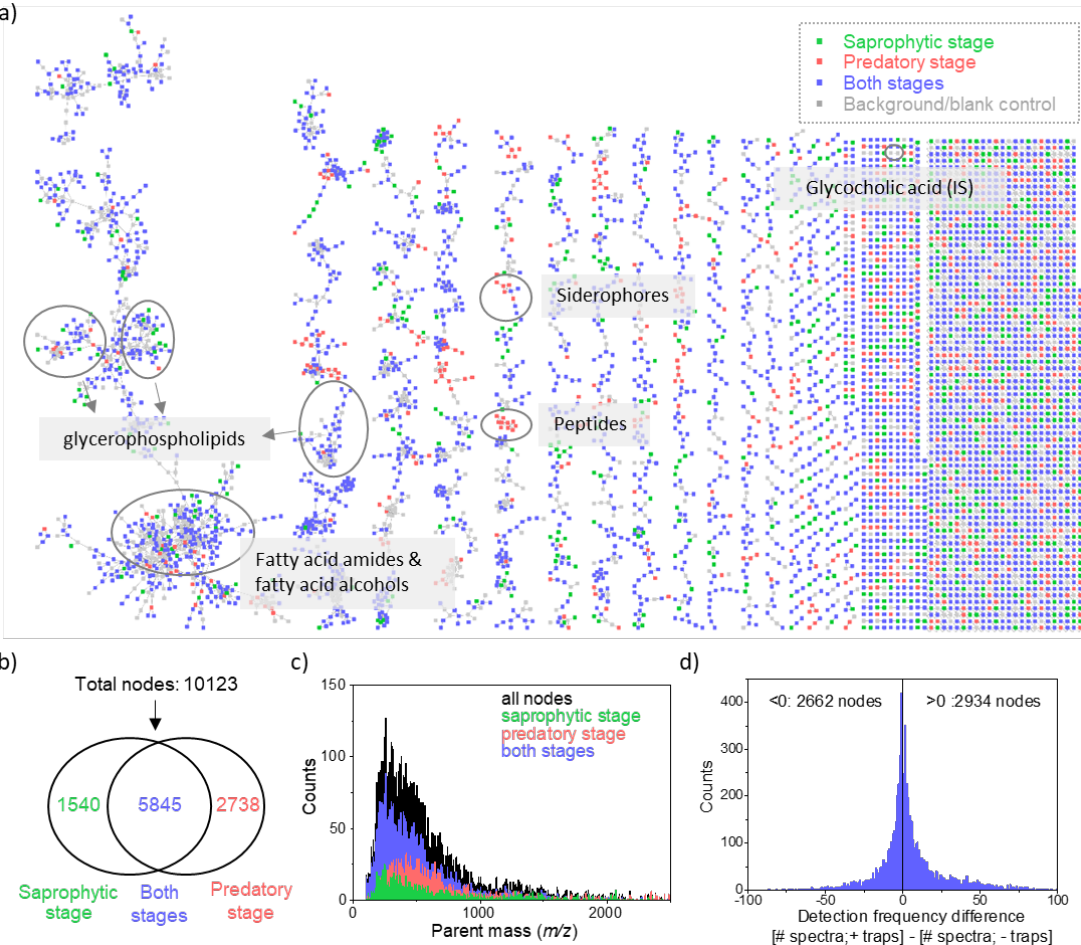
Figure 2. Arthrobotrys molecular network: visualization of metabolic diversity during the fungi- nematode interaction. ( a ) The molecular network of the isolated 100 Arthrobotrys strains (organic extract). The putatively identified metabolites are marked. Node colors represent sample groups at which the metabolites were detected. Nodes are colored based on whether they were found in the saprophytic stage (green), predatory stage (red), or in both stages (blue). Grey nodes originate from blank controls of media, worms, and internal standard (glycocholic acid). The molecular network of the aqueous extract is shown in Figure S1. ( b ) The Venn diagram and ( c ) m / z distribution of the parent mass of the 10,123 nodes in the molecular networks in Figure 2a and Figure S1. Nodes in the blank control samples were excluded. ( d ) The di ff erence in the detection frequency of the blue nodes between the predatory stage ( + traps) and the saprophytic stage ( − traps). Nodes with positive x -axis values represented that they were more frequently present in the predatory